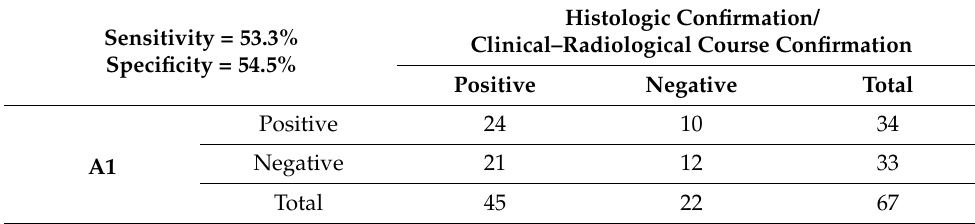
Table 6. Sensitivity and specificity of 68 Ga-DOTATOC-PET/CT A1 with histologic and clinical– radiological course confirmation.